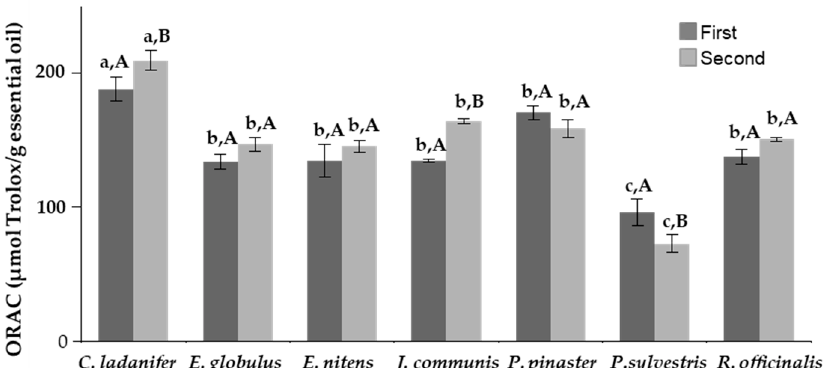
Figure 2. Antioxidant capacity (ORAC) of the essential oils ( µ mol Trolox/g) from plants collected in the first and second periods. Error bars correspond to the standard deviation of three replicates. ( n = 3). Different small letters mean significant differences ( p < 0.05) between all the samples analyzed, whereas different capital letters mean significant differences due to collection period.